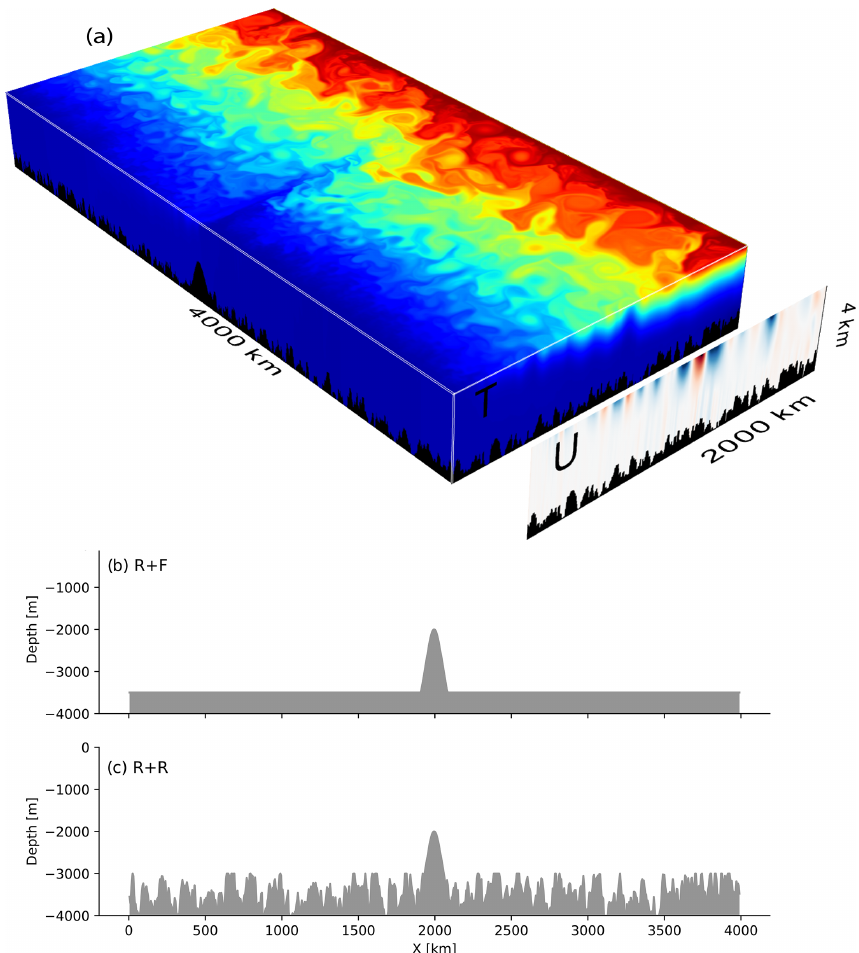
Figure 2. 3D representation (a) of instantaneous temperature (rectangular box, color scale ranges from 0 to 8 ◦ C) and zonal velocity (vertical section) for the simulation R + R after 200 years. The domain is a 4000km long by 2000km wide re-entrant channel. The maximum depth is 4000m with irregular bottom topography bounded at 3000m and a Gaussian-shaped ridge of 2000m located at x = 2000km, which limits the ACC transport and generates a standing wave downstream as seen in the surface temperature. Topography at y = 1000km in the two simulations: (b) R + F and (c) R + R. The rms height in R + R averaged within 50km × 50km areas out of the region of the ridge is